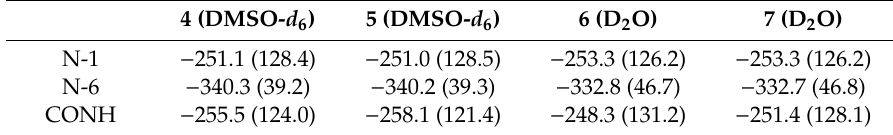
Table 3. 15 N NMR chemical shifts (ppm) a of compounds 4 – 7 .